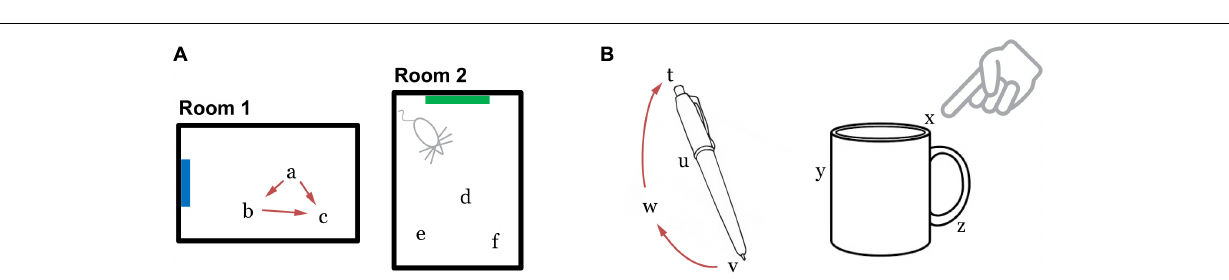
FIGURE 2 | (A) Grid cells in the entorhinal cortex represent locations of a body in an environment. The location representations are updated by movement (Room 1). The path integration property ensures that the representation of location c is independent of the path taken to get there. Locations are unique to each environment such that the representations of locations a , b , and c are distinct from the representations of any point in Room 2. (B) We propose that the neocortex contains grid cell analogs that represent locations relative to an object. The location representations are unique to each